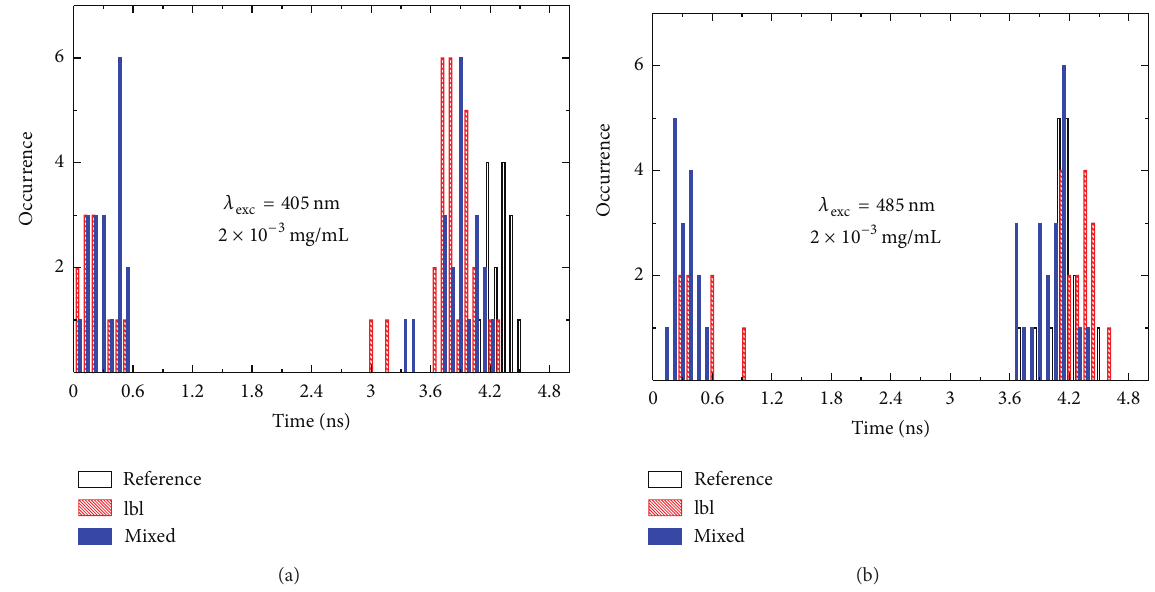
Figure 10: Histograms of fluorescence lifetimes of PCP complexes deposited on Ag nanowires for the layer-by-layer (red bars) and mixed (blue bars) samples. The results obtained for hybrid nanostructures are compared with the PCP-only reference (black bars). Decay times = 405 nm and (b) 𝜆 = 485 nm are extracted for the excitation wavelength of (a) 𝜆 exc exc